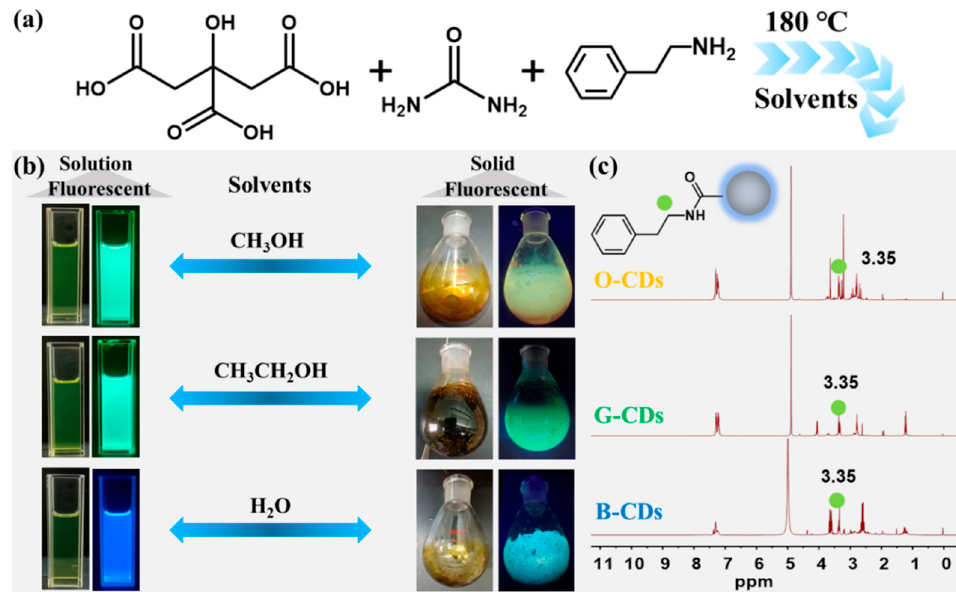
Figure 1. ( a ) Schematic illustration of the preparation of solid-state fluorescent CDs. ( b ) Actual photos of fluorescent CDs with different colour emissions. ( c ) 1 H NMR spectra of CDs in CD 3 OD.